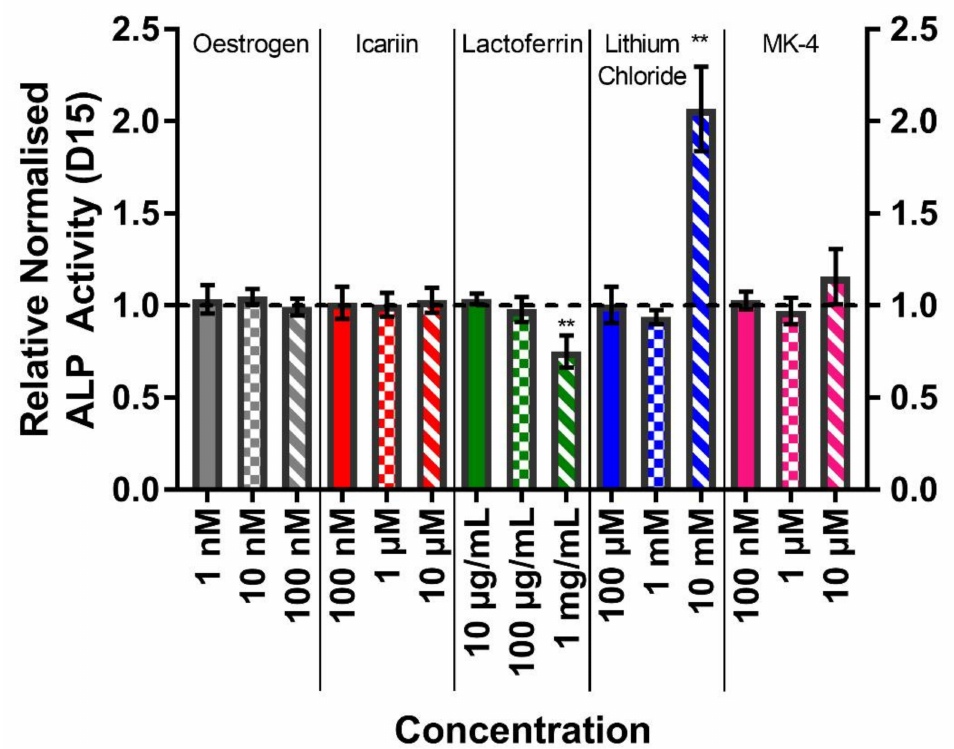
Figure 5. The e ff ect of each compound and concentration on the normalised ALP activity at day 15, normalised to their respective vehicle control (horizontal dashed line). The treatment with lactoferrin (1 mg / mL) resulted in a significantly lower normalised ALP activity, whilst the treatment with lithium chloride (10 mM) elevated the normalised ALP activity by 100% (both p < 0.01). No other